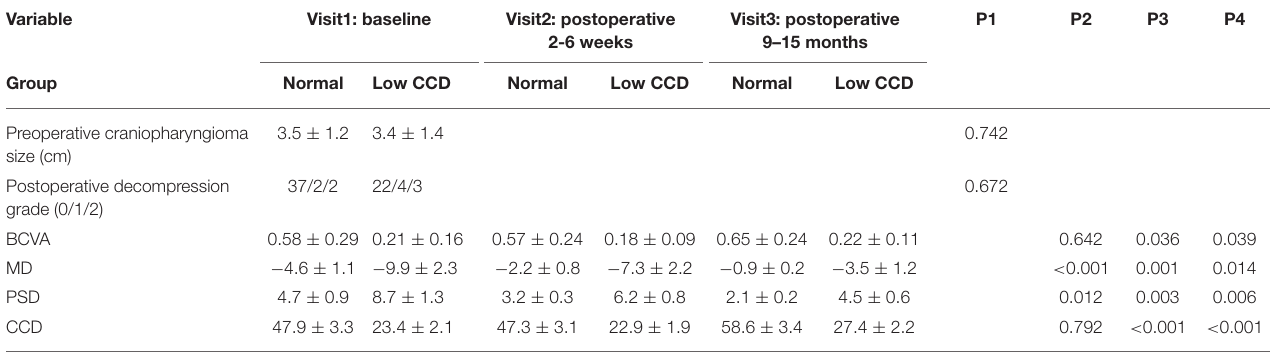
TABLE 2 | Comparison of the visual prognosis of the low CCD group and the normal CCD group after decompression.